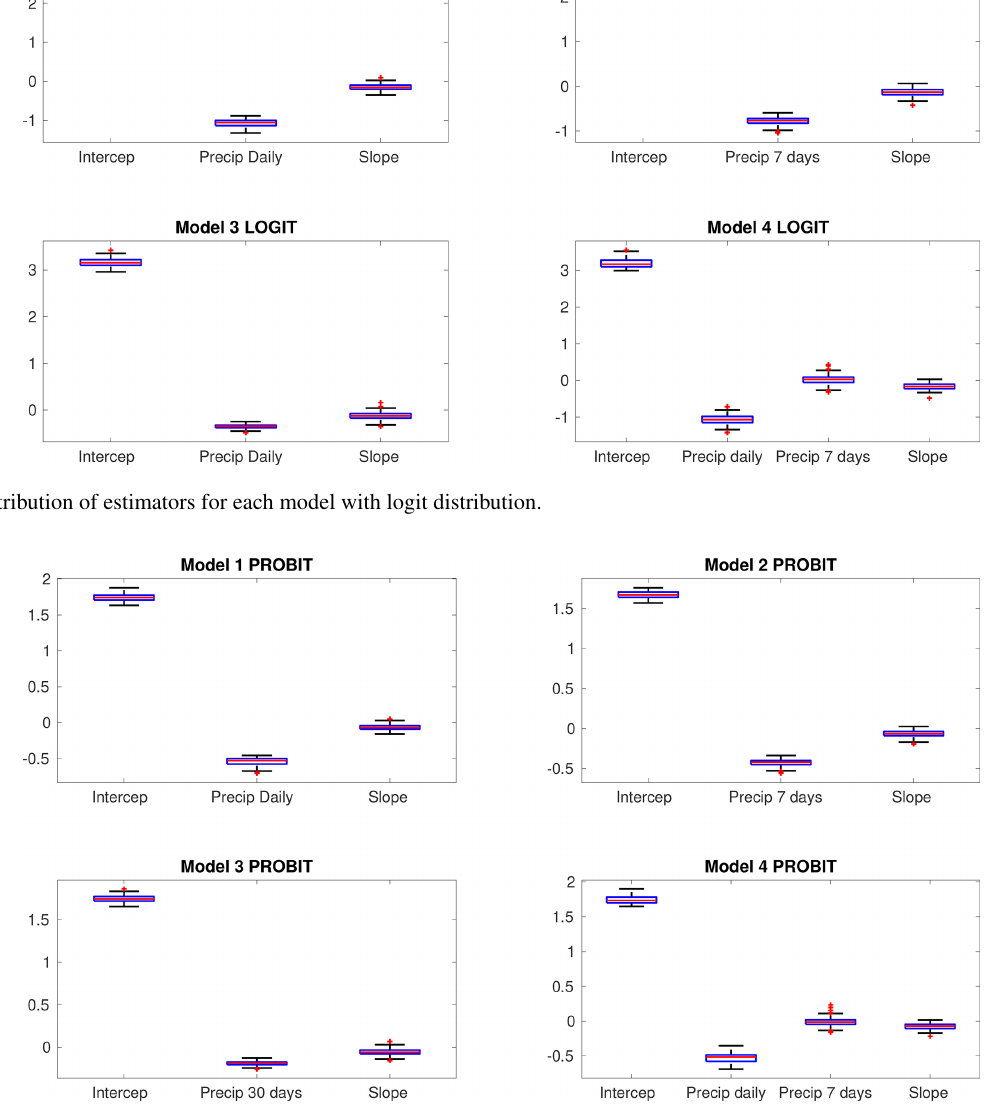
Figure 6. Distribution of estimators for each model with probit